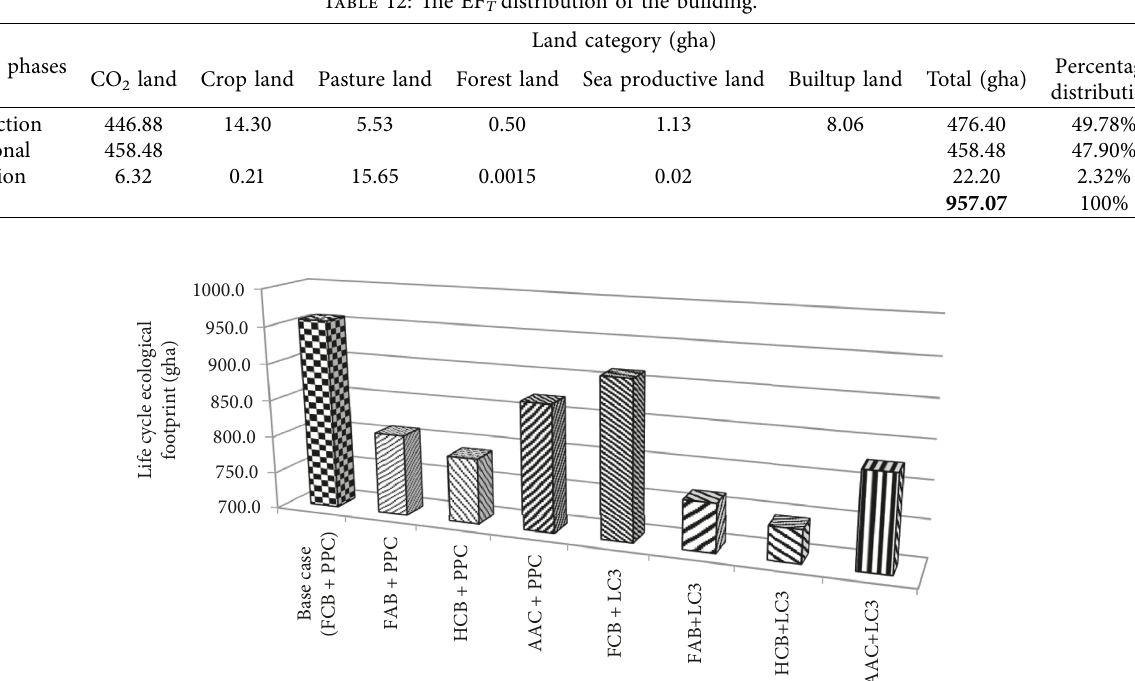
Table 12: The EF T distribution of the building.